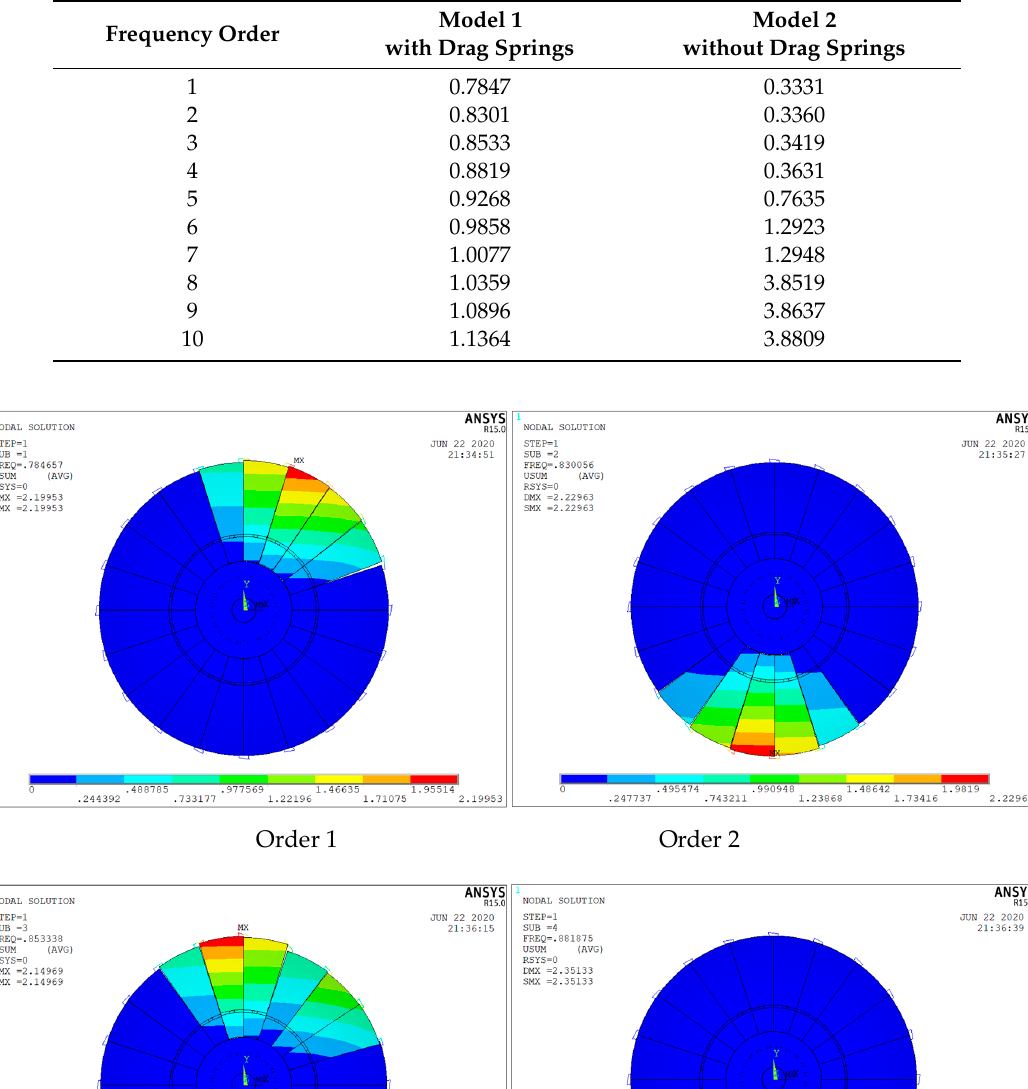
Table 5. Natural frequencies (Hz) of Mode 1 and 2.